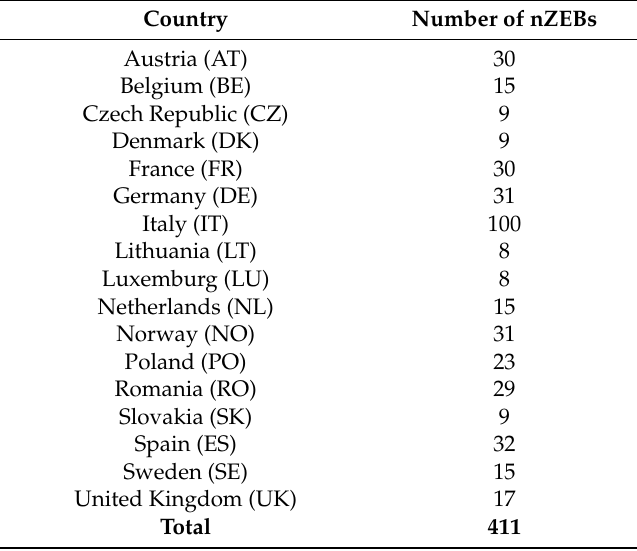
Table 1. Number of nZEBs collected in each European